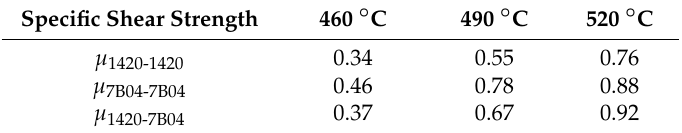
Table 3. Specific shear strength of the three diffusion couples bonded under different temperatures. Specific Shear Strength